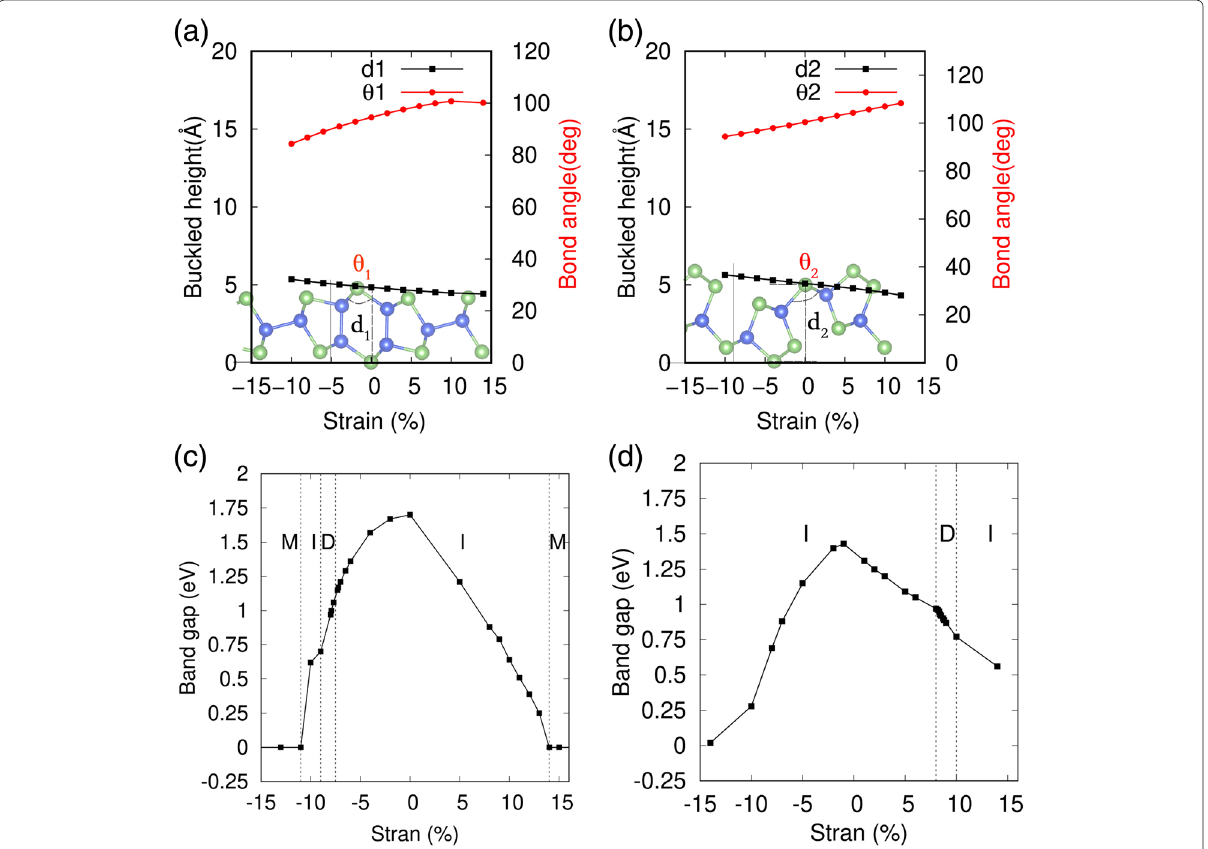
Fig. 5 Strain effects on the geometric structures and band gaps of 2D SiAs and SiAs 2 . a , c represent SiAs; and b , d denote SiAs 2 ; M, I, and D represent metal, indirect semiconductor, and direct semiconductor,